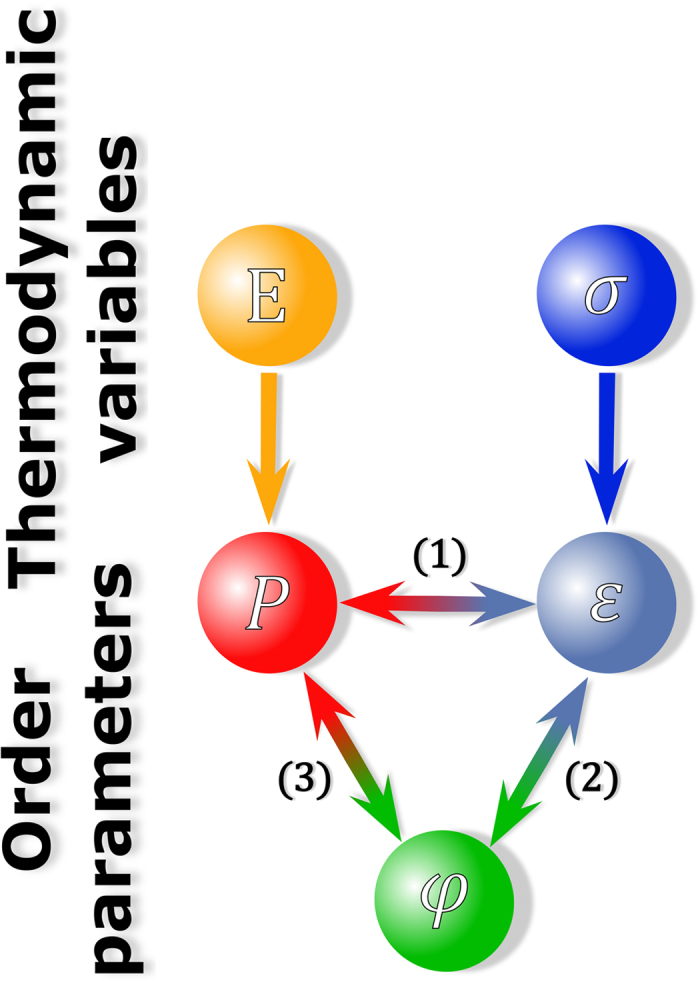
Thermodynamic variables electric field E and stress σ are conjugated to the order parameters polarization P and strain ε, respectively.Coupling between the order parameters polarization P and strain ε is termed piezoelectricity/electrostriction (1), between strain ε and oxygen ochtaedral tilts ϕ is termed rotostriction (2), and between polarization P and oxygen ochtaedral tilts ϕ is termed in this work as rotopolarization (3).